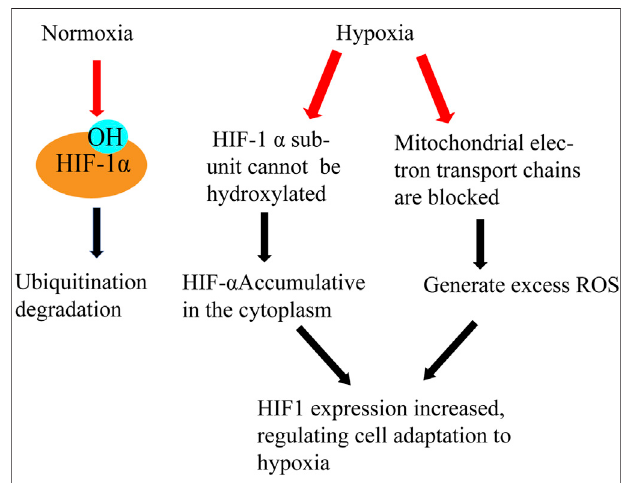
FIGURE 7 | Hypoxia and HIF. Effects of normoxia and hypoxia on HIF- α Different processing results in different functions of HIF and the generation of